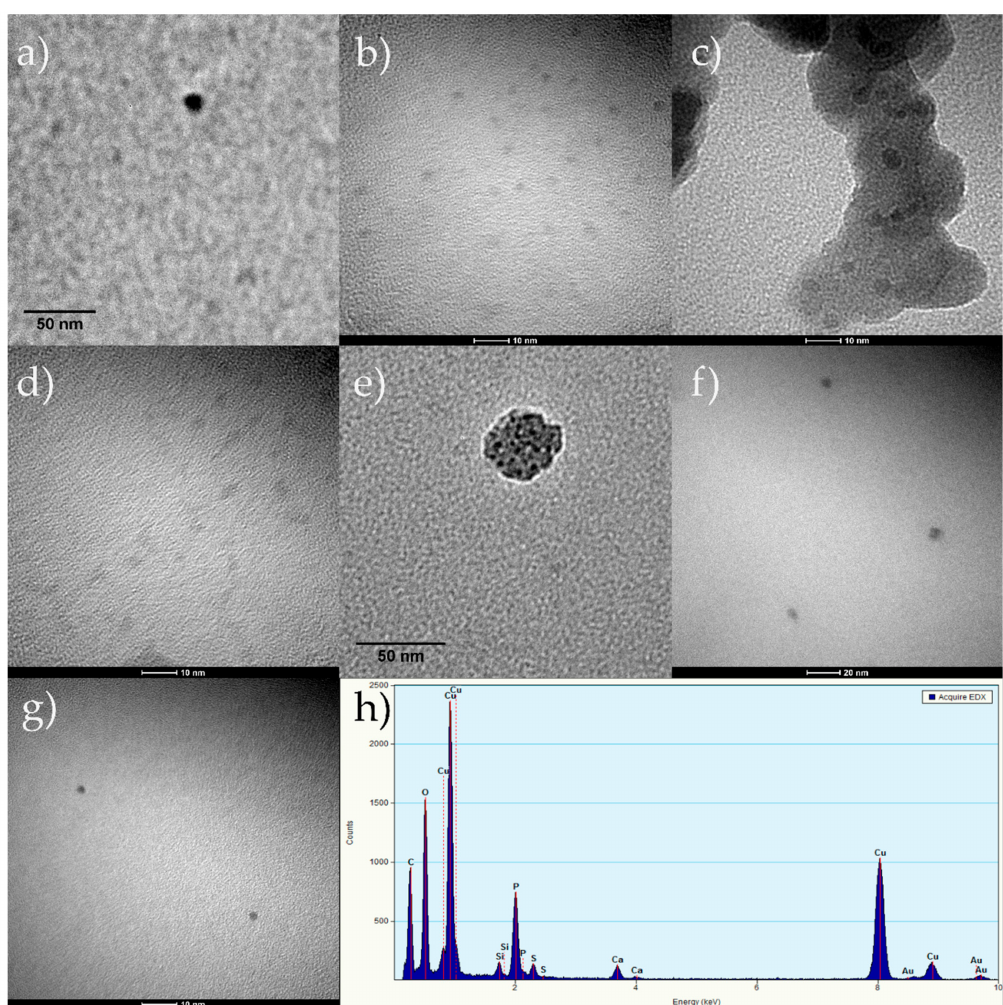
Figure 1. Transmission electron microscopy (TEM) images of the products of the CuSO 4 reduction by different protein fractions from the algal extract: ( a ) fraction 3; ( b ) fraction 4; ( c ) fraction 5; ( d ) fraction 6; ( e ) fraction 7; ( f ) fraction 8;